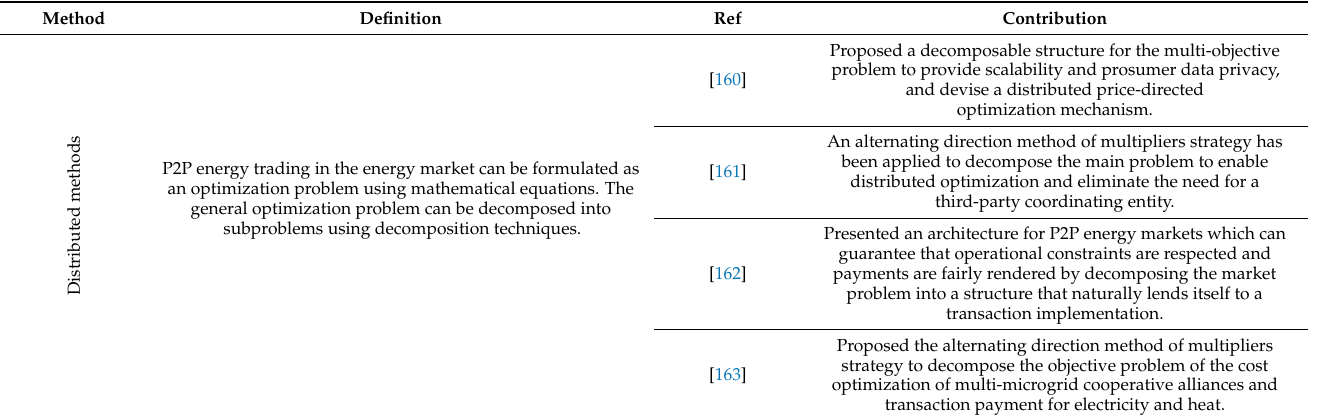
Table 6. The existing energy trading methods for P2P